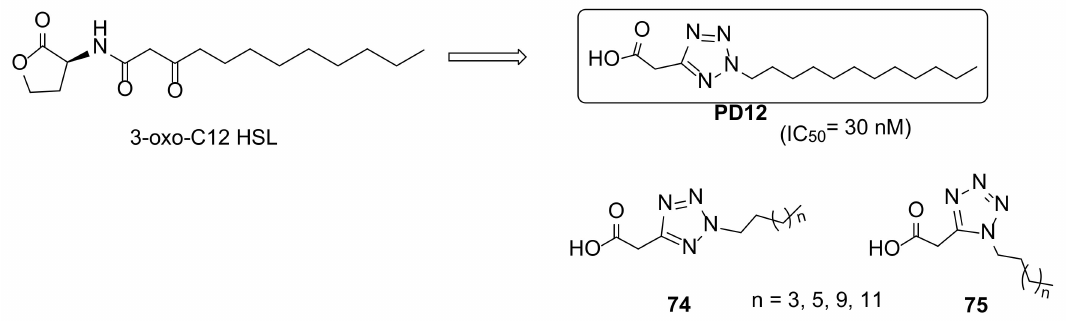
Figure 10. Tetrazole-containing QS inhibitor screened against LasR by Greenberg’s